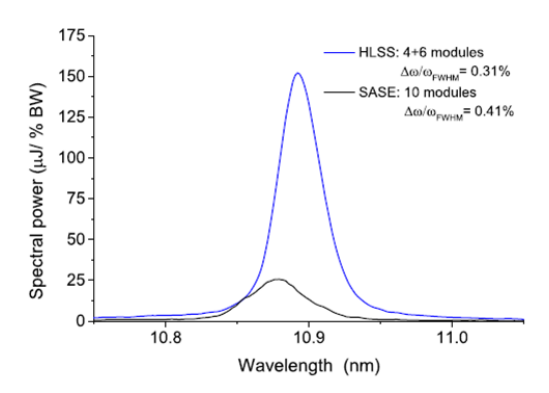
Figure 8. Spectral bandwidth for SASE and HLSS in the same experiment.